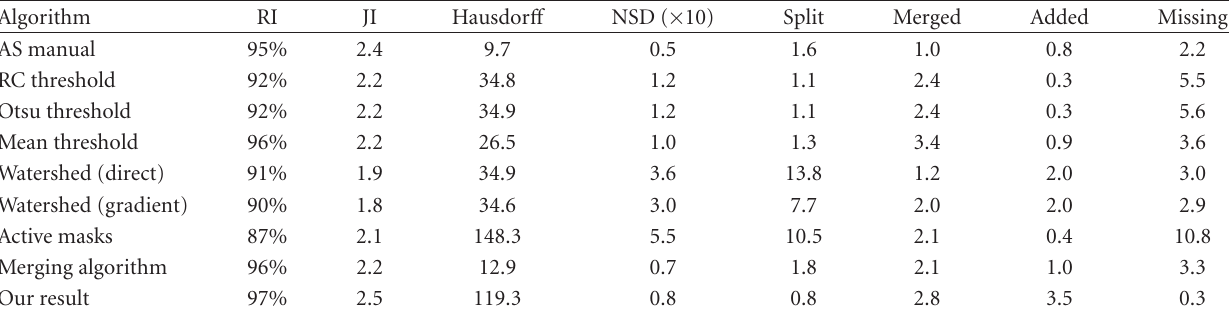
Figure 6: Segmentation of Nuclei: (a) original image, (b) our result, and (c) ground truth. Table 4: Quantitative comparison of nuclei